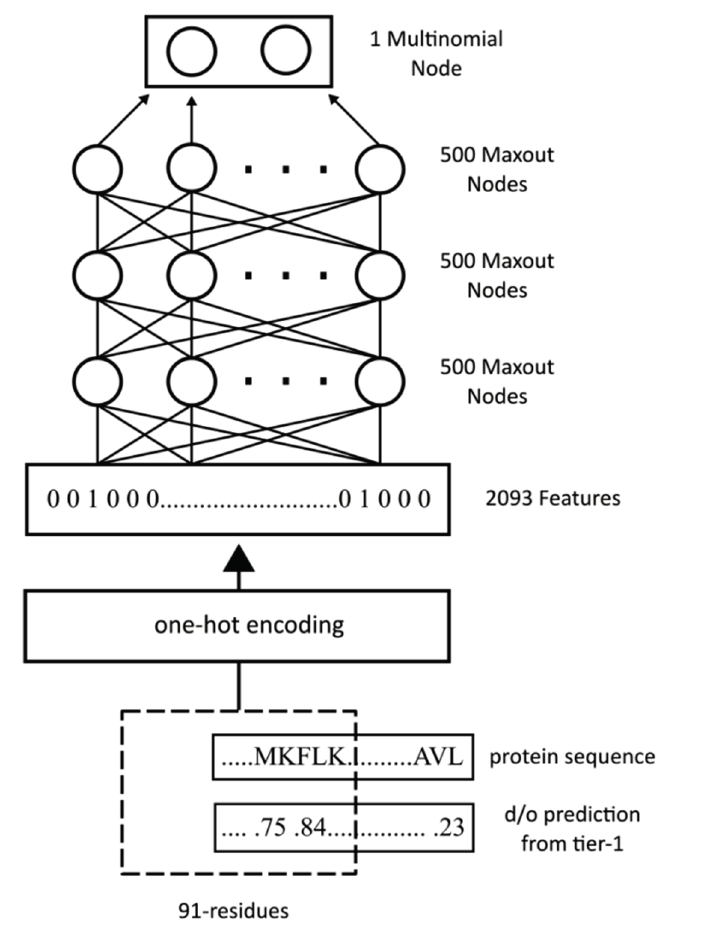
Figure 5. Tier 2 deep network architecture used to make final order/disorder